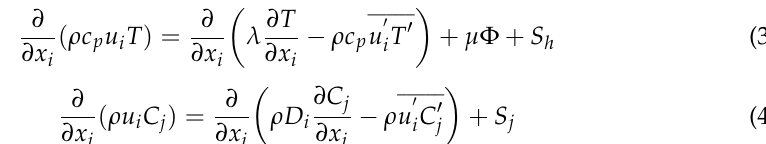
Figure 2. The schematic diagram for the meshed geometry shows a closer view of the inlet and outlet injection.